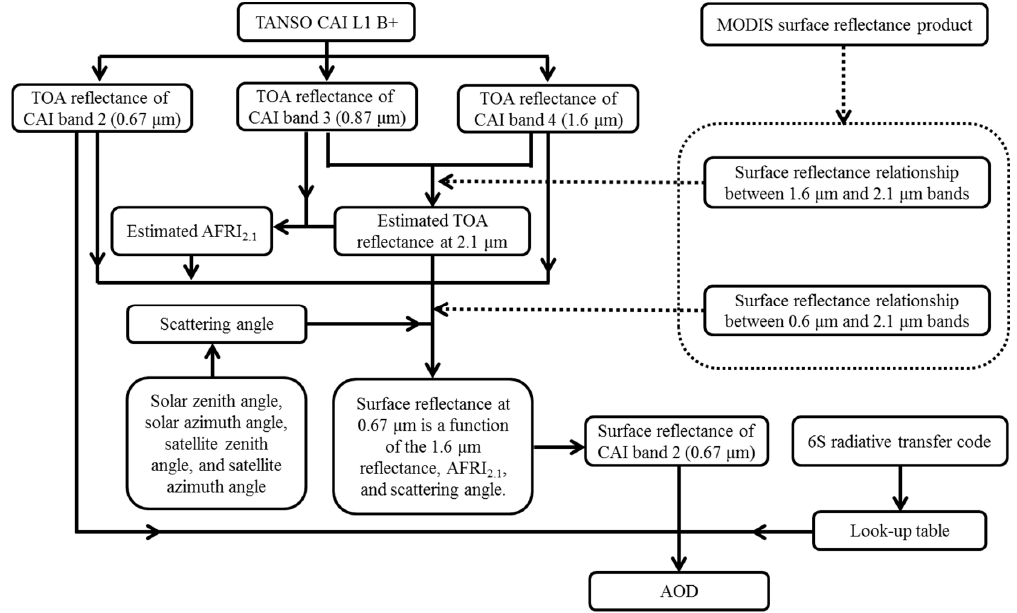
Figure 8. Flow chart of the GOSAT TANSO-CAI retrieval procedure. Dashed lines indicate the analysis of the relationship between associated bands using MODIS surface reflectance products. Table 2. The input parameters of the 6S radiation transfer code for a pre-computing look-up table. Parameters